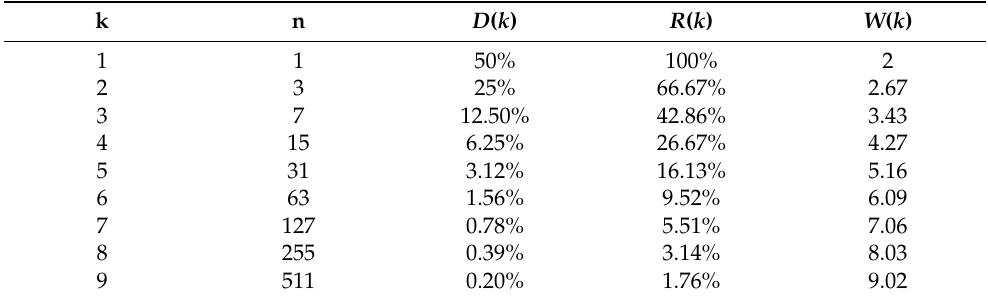
Table 1. The relationship between ( k , n ) and modification density, embedding rate, and embedding